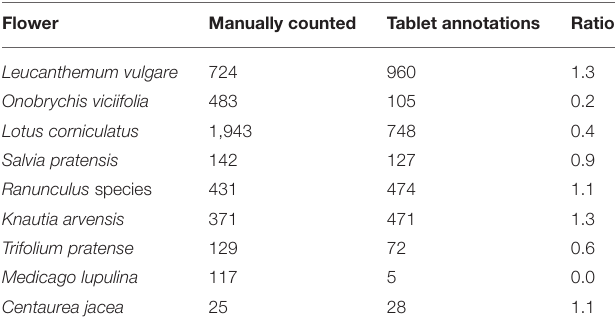
TABLE 2 | Comparison of selected manually counted total numbers with tablet annotations.